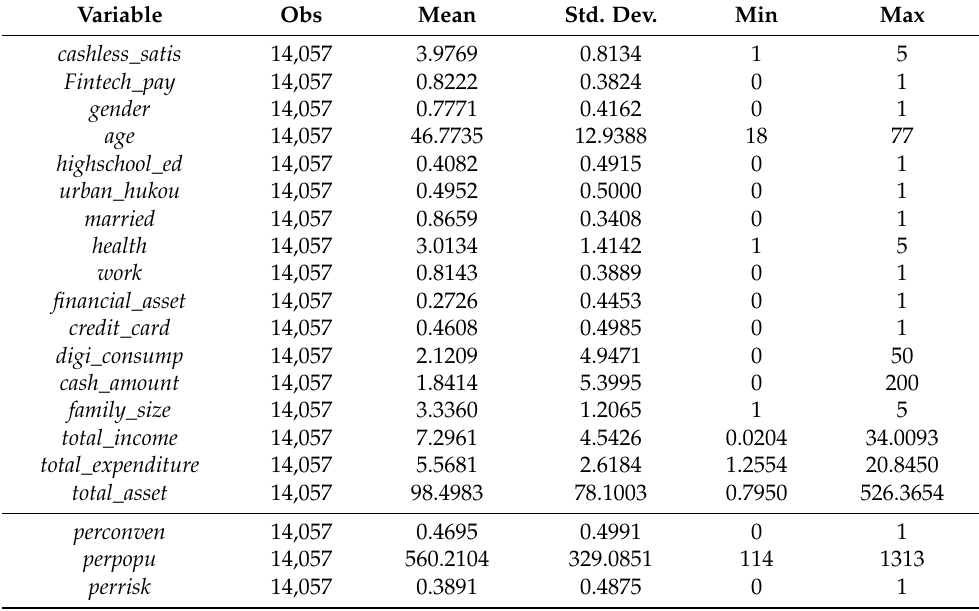
Table 2. Descriptive